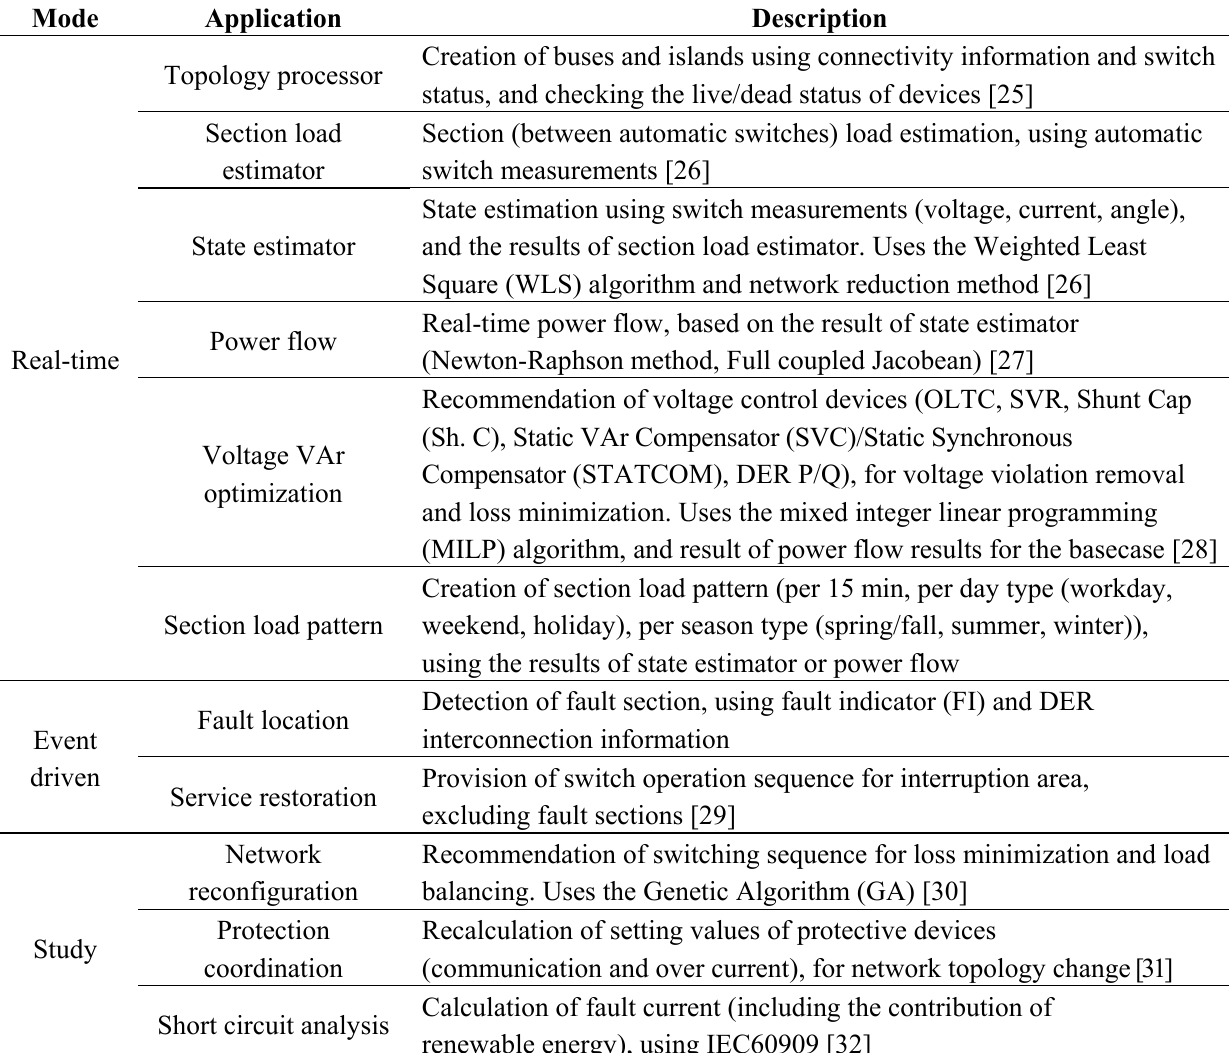
Table 3. Development of KSDMS application